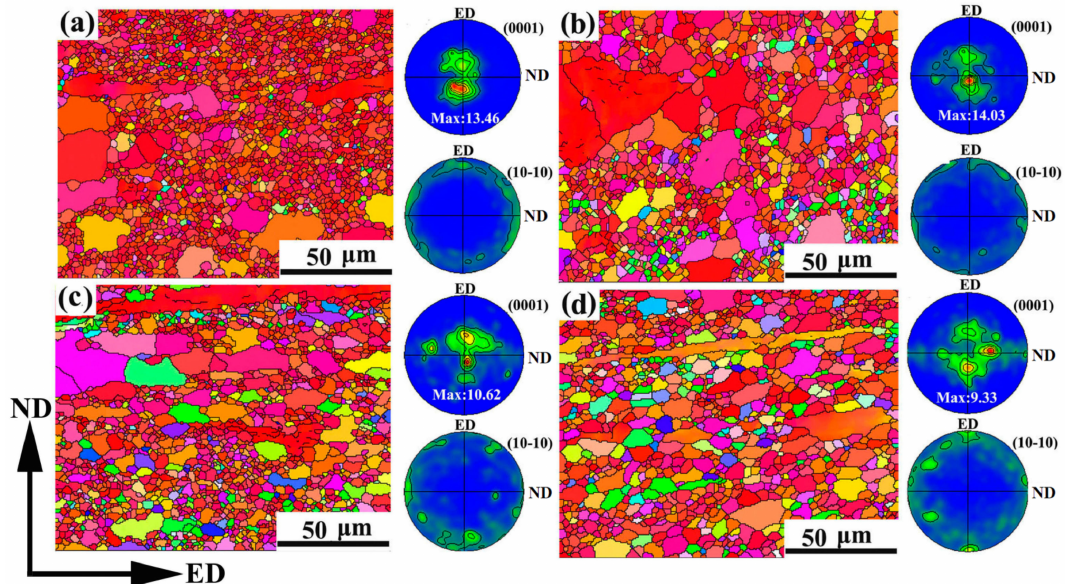
Figure 3. EBSD inverse pole figure maps and (0001) and (10-10) pole figures from the ED–ND plane of the as-extruded Mg-1.0Sn-0.5Ca-xZn alloys: ( a ) TX10 alloy; ( b ) TXZ100 alloy; ( c ) TXZ101 alloy; ( d ) TXZ102